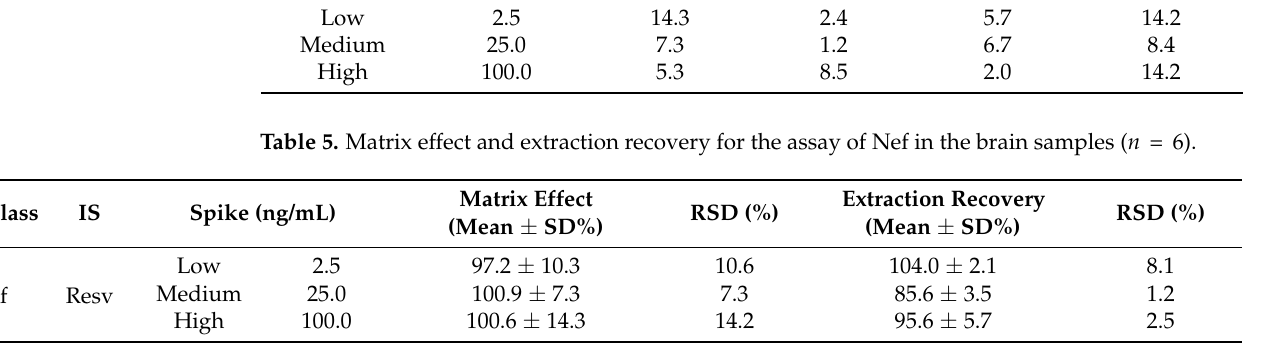
Table 4. Intra-day and inter-day accuracy, precision and recovery of Nef from the biological samples (3days with six replicates per day). Compound (ng/mL)